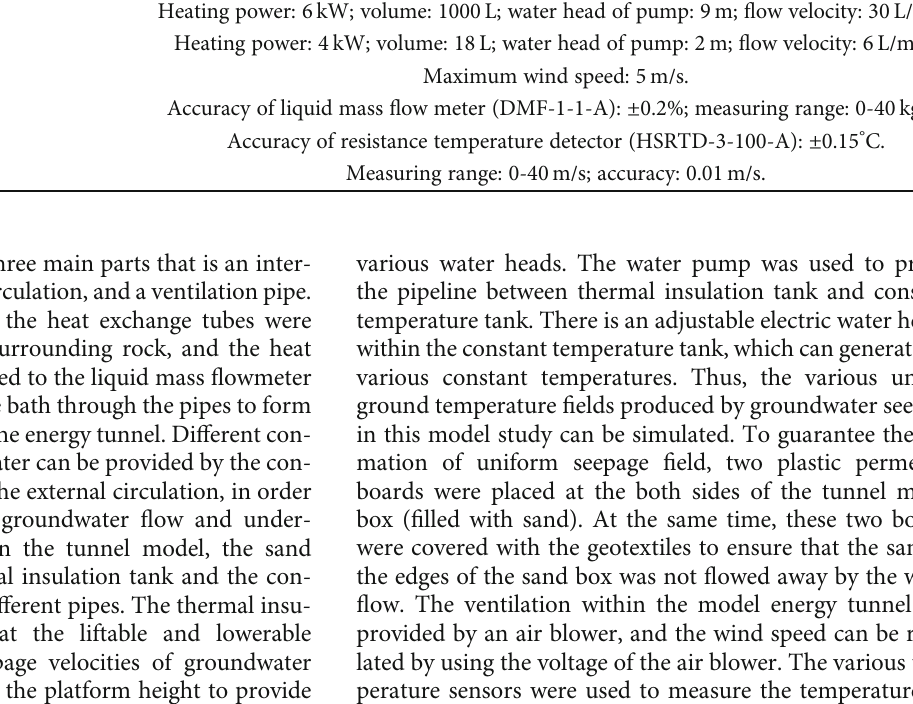
Figure 3: Testing equipment used in the laboratory model experiment and layout of heat exchangers on the lining of the energy tunnel model. Table 1: Experimental devices of thermal response model tests for the energy tunnel. Experimental devices Speci fi cations Thermal insulation